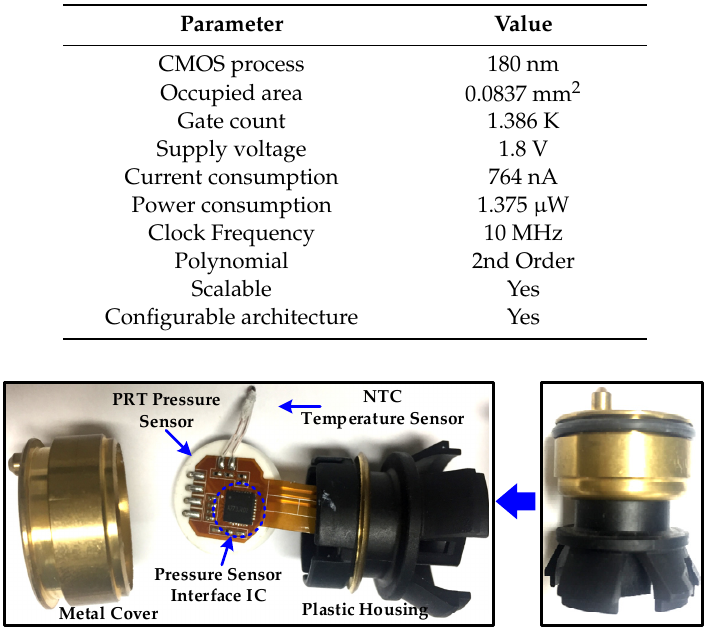
Table 2. TCC performance summary.